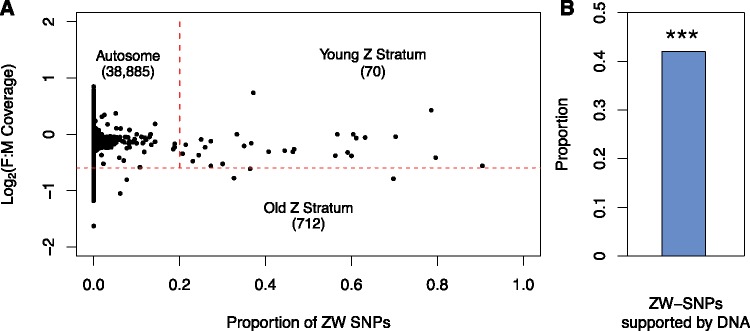
—Identification of undifferentiated ZW region. (A) Coverage and proportion of ZW SNPs on each scaffold. Scaffolds below the horizontal red dashed line are defined as Z-specific based on their log2(female:male) coverage ratio. Autosomal scaffolds are above the horizontal red dashed line and to the left of the vertical red dashed line. Young Z scaffolds are above the horizontal red dashed line and to the right of the vertical dashed line, and are defined by having >20% of the SNPs consistent with ZW-inheritance. The number of transcripts in each category is given in parentheses. (B) The proportion of sex-chromosome consistent SNPs in the RNA data that are also consistent in the DNA sequencing data set. Only SNPs on scaffolds with >20% of SNPs supporting a ZW karyotype in the RNA data set (putative young ZW strata) were considered. *** denotes a significant enrichment in the proportion of ZW-consistent SNPs in the RNA that were also ZW-consistent in the DNA, compared with the same proportion for all SNPs identified in the RNA (P < 2.2×10−16).